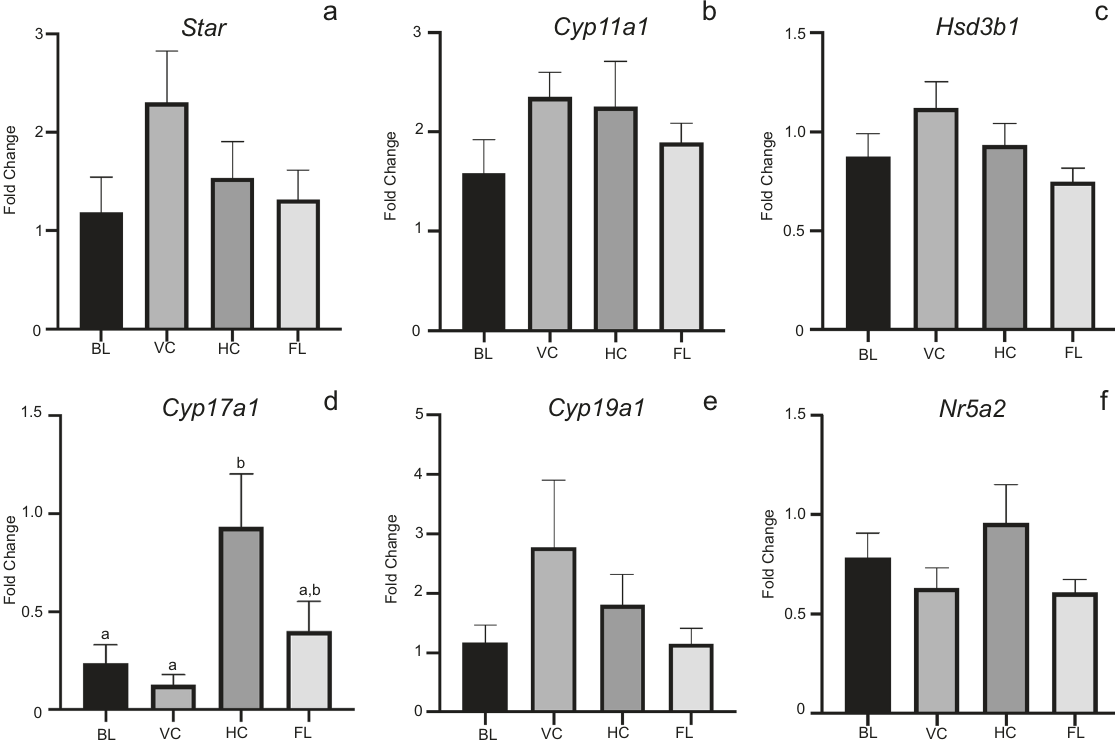
Fig. 4 Whole ovarian tissue steroidogenic gene expression was not altered by space fl ight. Histograms depict relative fold change ( ΔΔ Ct method) for a Star , b Cyp11a1 , c Hsd3b1 , d Cyp17a1 , e Cyp19a1 , and f Nr5a2 following normalization to 18S; n = 8 – 10/treatment group; 10BL, 10VC, 8HC, 10FL). a,b Means ± SEM with different superscripts are signi fi cantly different ( p ≤